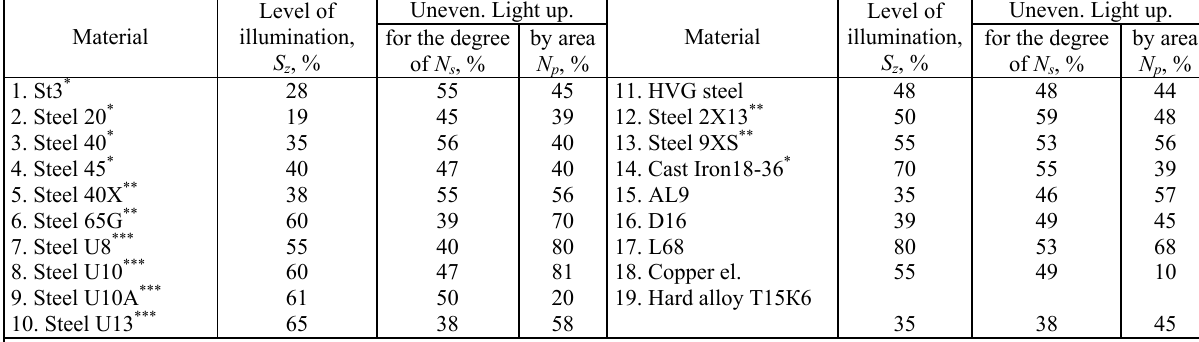
Table 1 – The results of the evaluation of the chemographic effect of the experimental samples